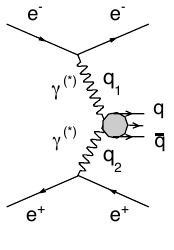
Figure 1: The Feynman diagram for the two-photon fusion